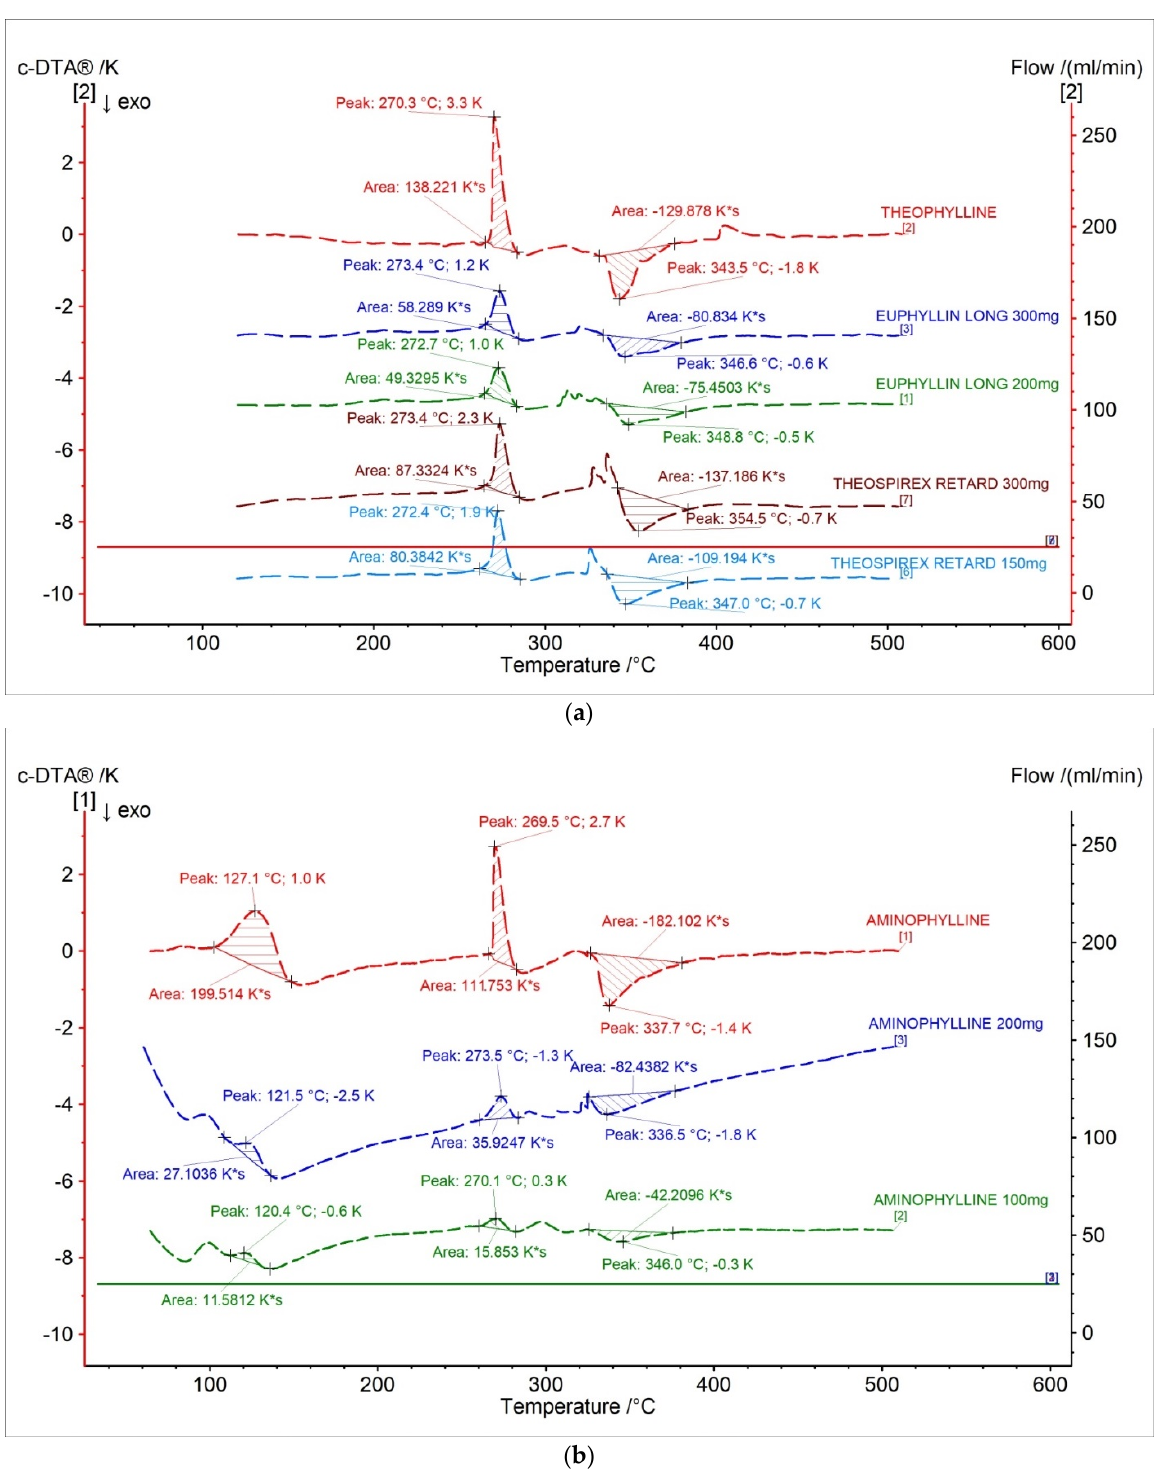
Figure 6. c-DTA curves for ( a ) theophylline standard, ( b ) aminophylline standard, and pharmaceutical preparations containing theophylline and aminophylline.